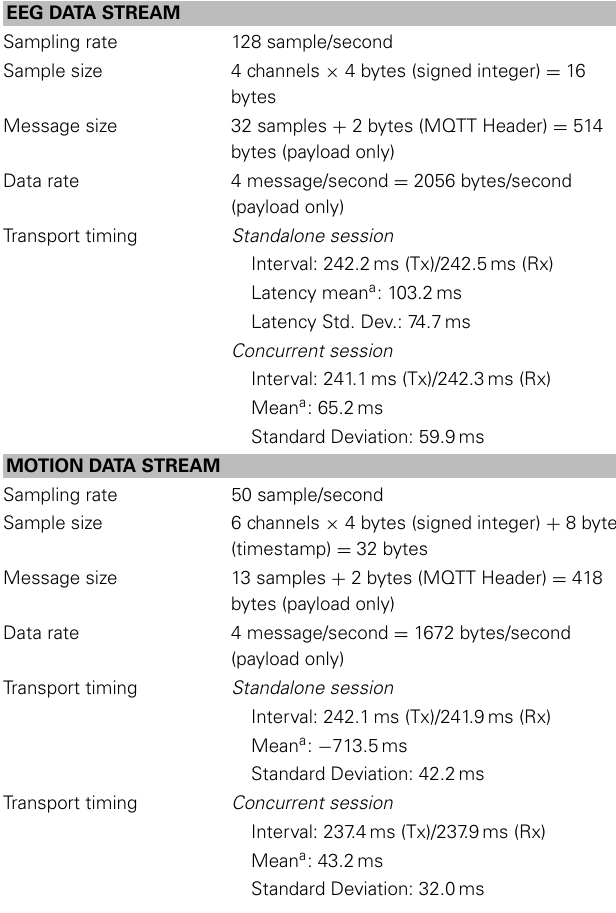
Table 2 | Performance measurements of synchronous BCI data streaming over